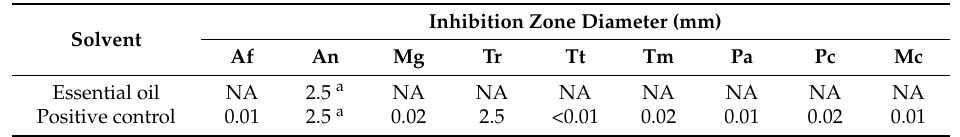
Table 4. Minimum inhibitory concentrations (MIC) of the H. africana essential oils against the tested opportunistic